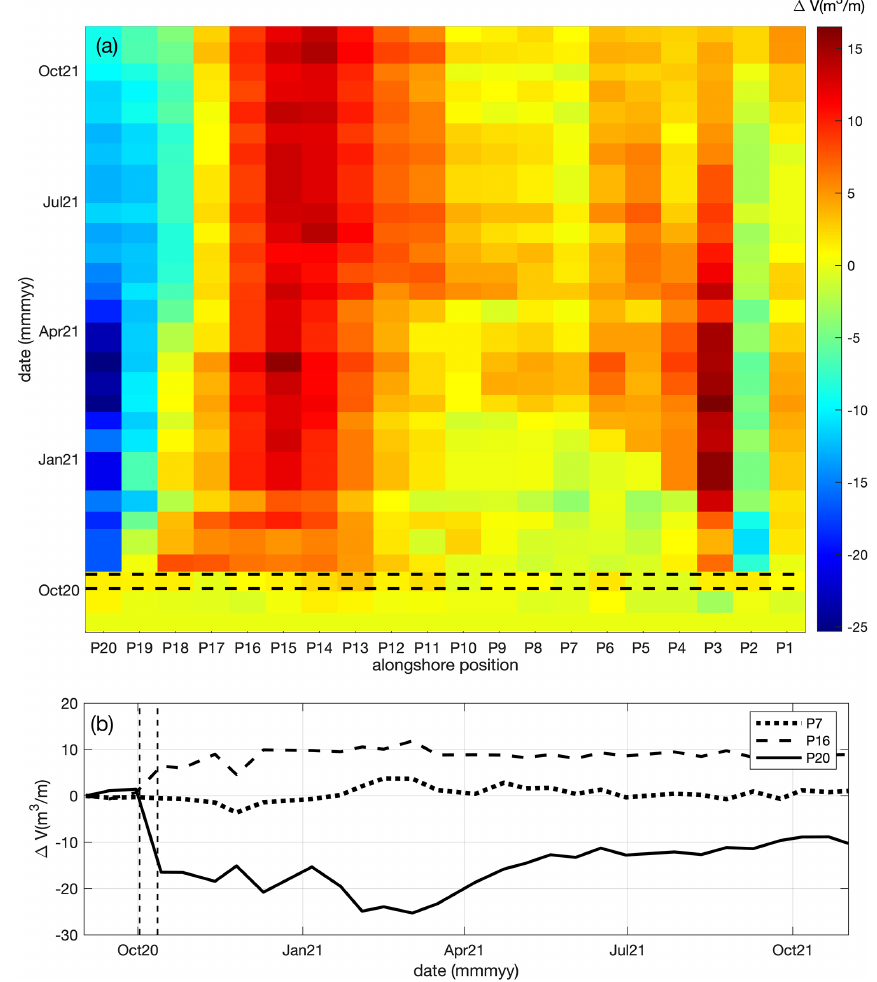
Figure 15. (a) Subaerial volume change evolution for beach profiles located east of the port’s jetty (storm period for Gamma and Delta: vertical dashed lines) and (b) time series of volume change for selected transects with different post-storm behavior (P7 – stable, P16 – accretion, P20 – erosion followed by